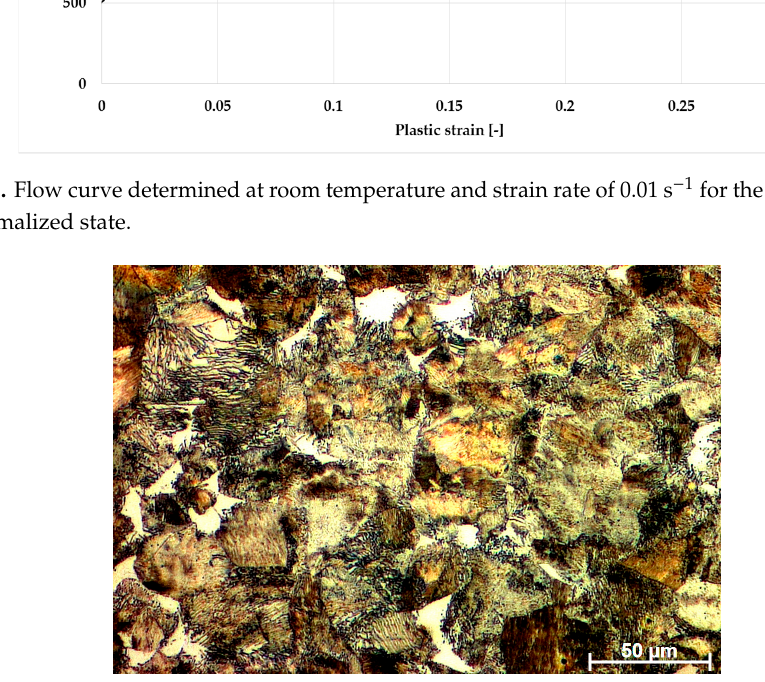
Figure 4. Perlitic-ferritic microstructure of the normalized material.